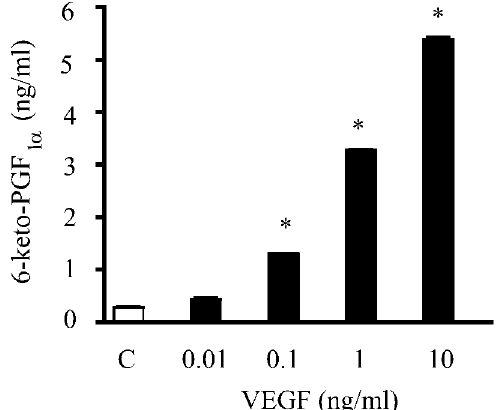
FIG. 3. Dose-dependent effects of VEGF (0.01–10ng/ml) on COX activity in HUVEC. COX activity was measured by the formation of 6-keto-PGF 1 a in the presence of exogenous arachidonic acid (10 m M, 10min). Data are expressed as mean ± standard error of the mean of 12 determinations from at least four separate experimental days. * p < 0.05 when compared with untreated HUVEC at 24h